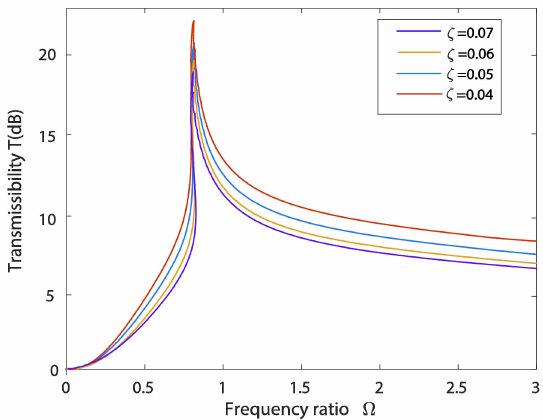
Figure 15. The absolute displacement transmissibility of the QZS-IE seat suspension system with different damping ratios ( µ = 0.4, λ = 0.2, u 0 = 1.0, ε =